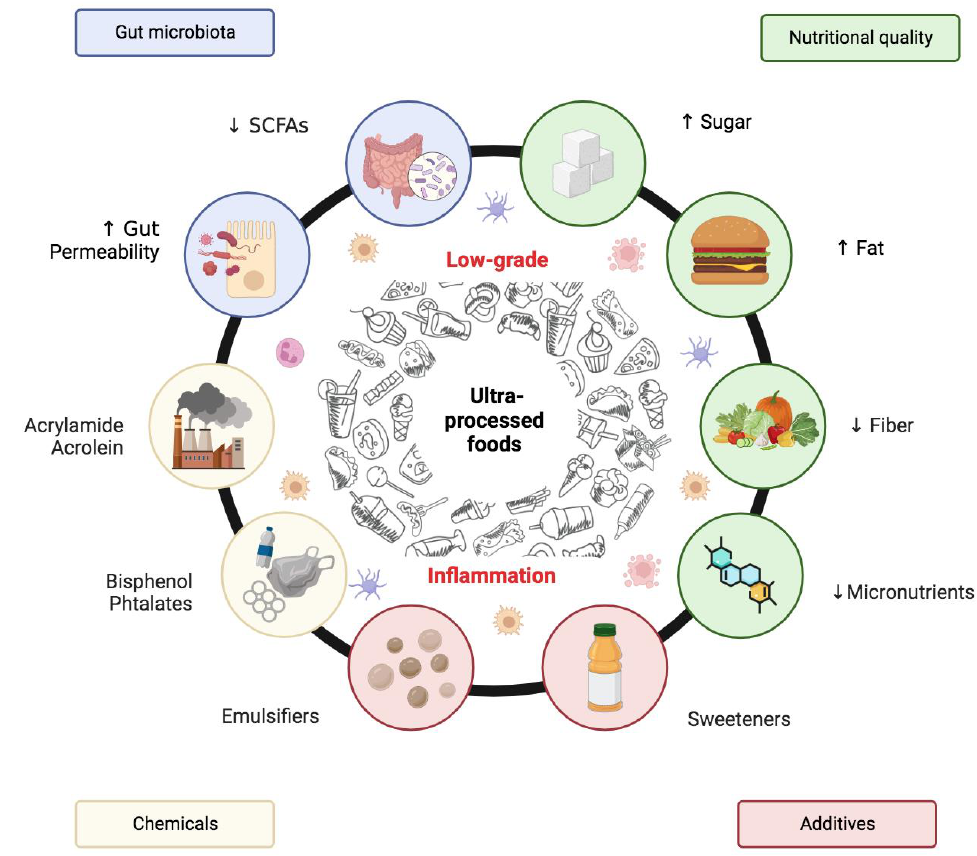
Figure 2. Possible mechanisms explaining the relationship between UPF and low-grade inflammation. ↑ increased; ↓ reduced.